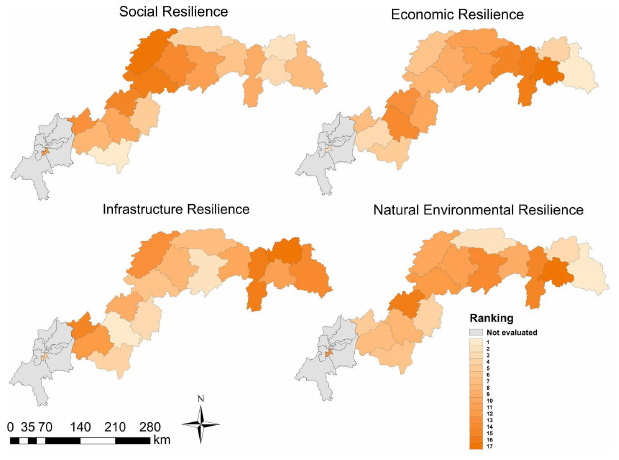
Fig. 7 . Disaster resilience ranking for the four subsystems in the Three Gorges Reservoir